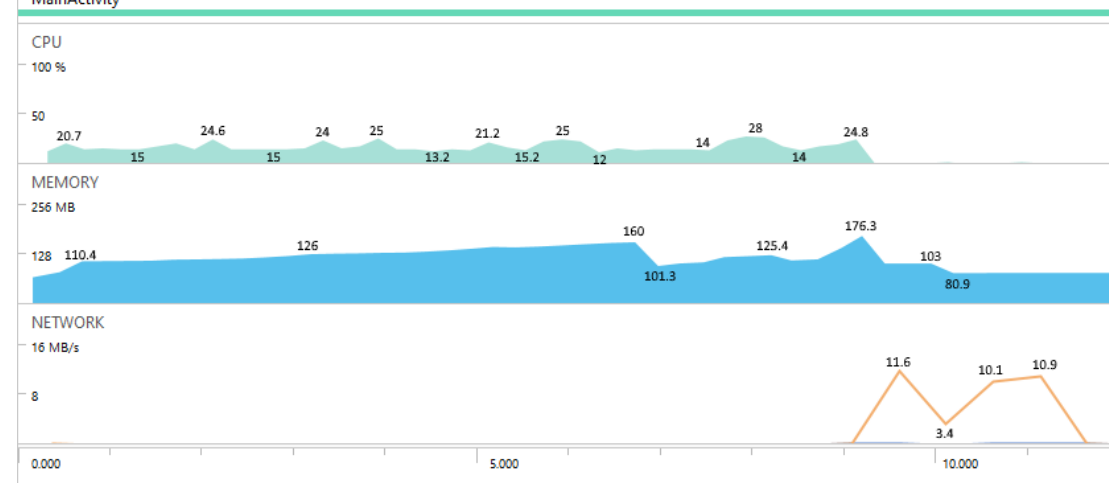
Figure 8. Single file uploads of 15 MB.